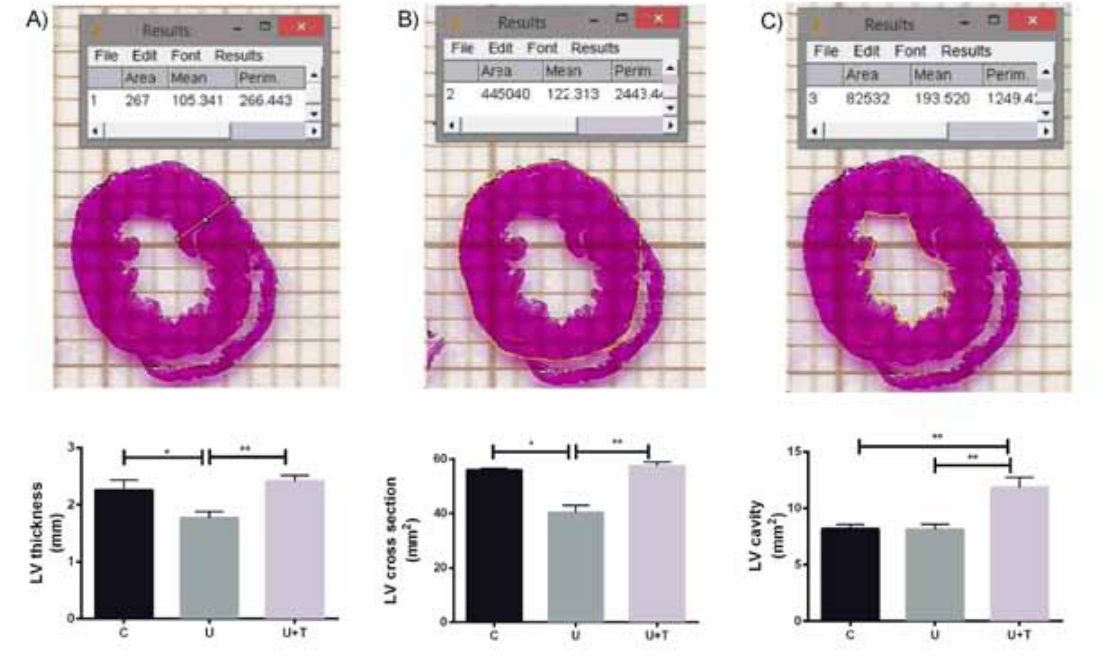
Figure 1: Effect of maternal low-protein diet and moderate physical training on cardiac morphology. Left ventricle thickness (A), cross-section (B) and cavity area (C) in male offspring at 120 days of life. C= Control group; U= undernourished group; U+T= undernourished plus 8 weeks of moderate physical training group. Data are shown as mean + SEM for 4-6 animals per group. *p<0.05; ** p<0.01